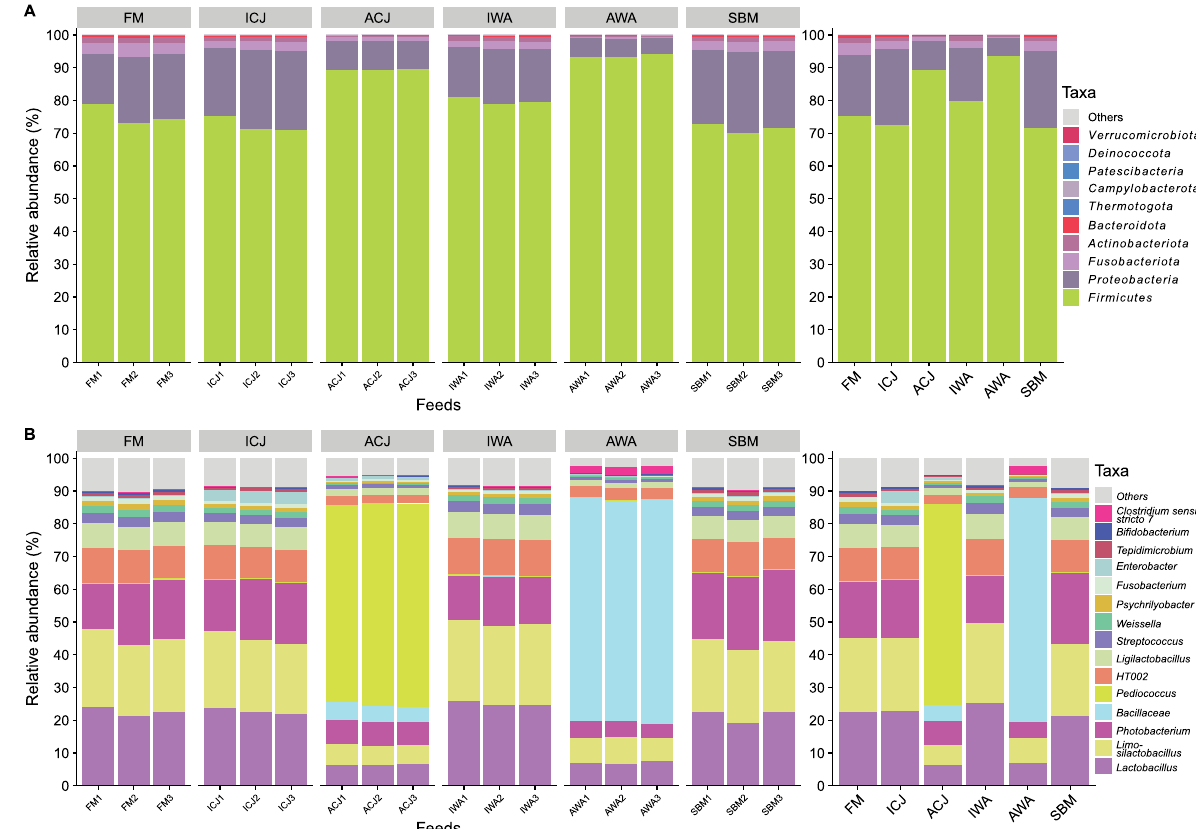
Fig. 1 Microbiota composition in the feed samples. Relative abundance of the top 10 most abundant taxa at phylum level ( A ) and top 15 most abundant taxa at genus or lowest taxonomic rank ( B ). The mean relative abundance of each taxon within the same diet is displayed on the right side. The samples are grouped by diets; FM—fishmeal-based; SBM—soybean meal-based; 4 experimental diets containing 300 g/kg SBM and 100 g/kg of ICJ—inactivated Cyberlindnera jadinii ; ACJ—utolyzed C. jadinii ; IWA—inactivated Wickerhamomyces anomalus ; AWA—autolyzed